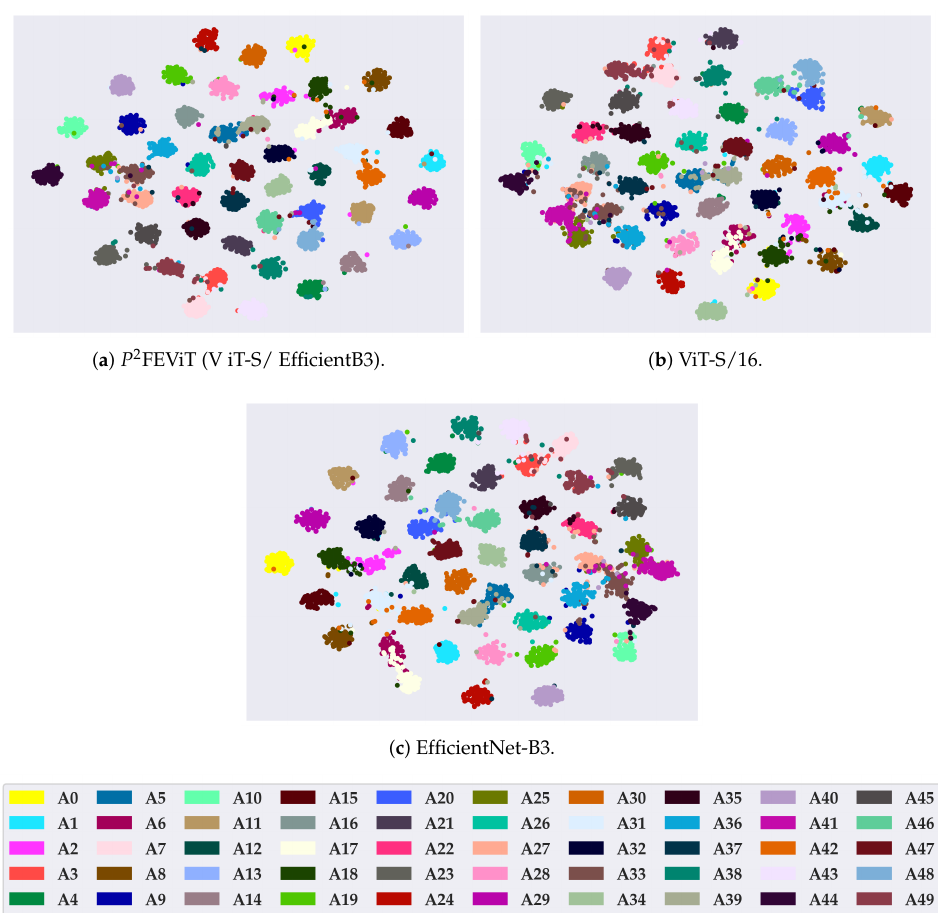
Figure 16. Two-dimensional scatterplots of high-dimensional features on the BIT-AFGR50 dataset (training ratio = 20%). ( a ) P 2 FEViT (V iT-S/ EfficientB3). ( b ) ViT-S/16. ( c )